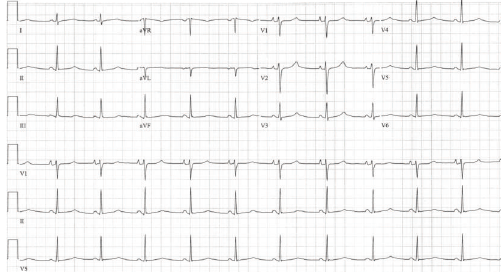
Figure 2: ECG obtained after AF cardioversion, showing sinus rhythm with QTc of 500ms.